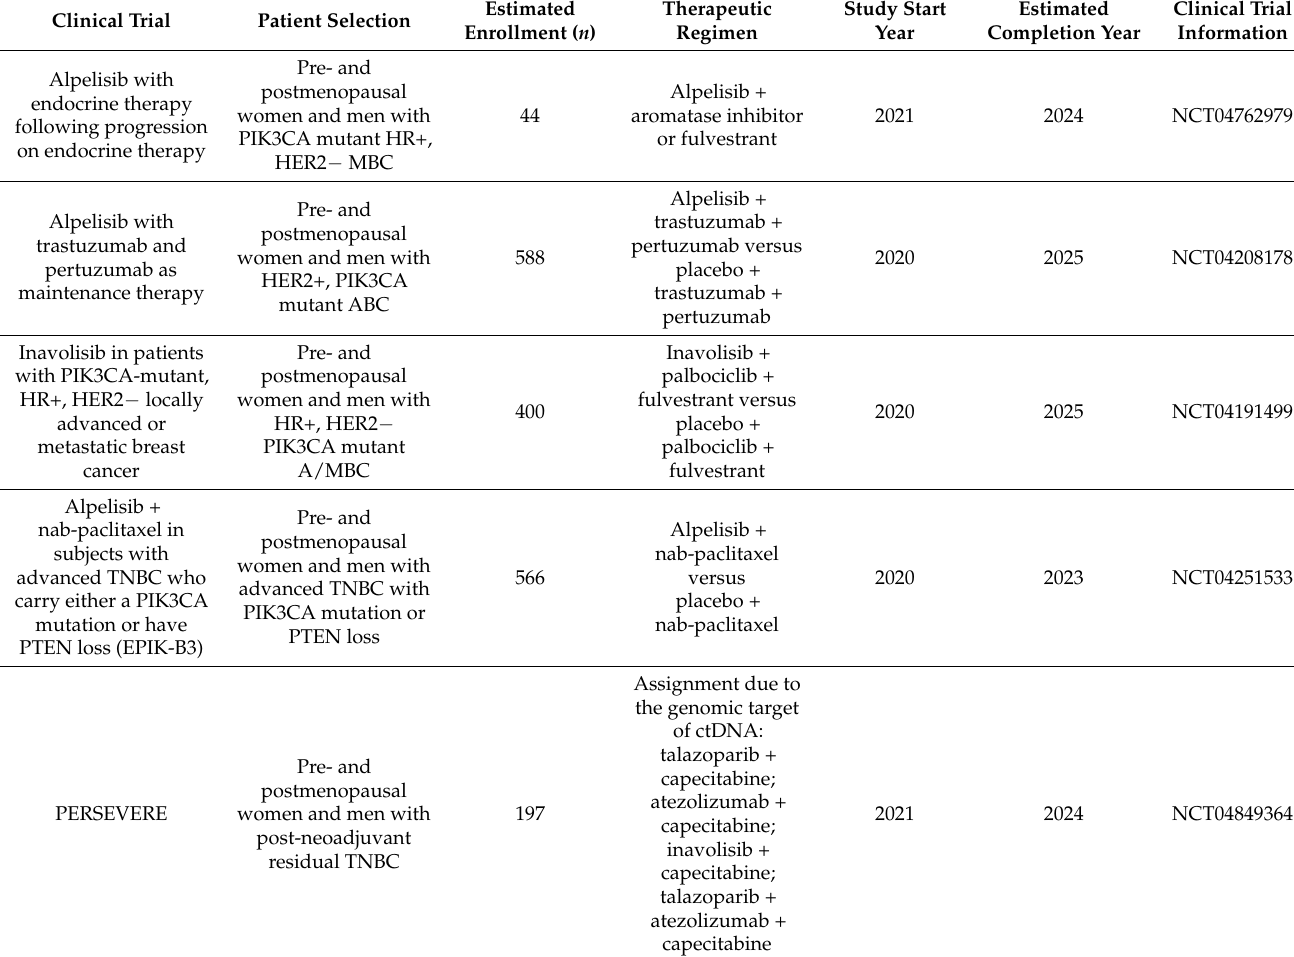
Table 3. Selected ongoing trials with PI3K inhibitors in patients with breast